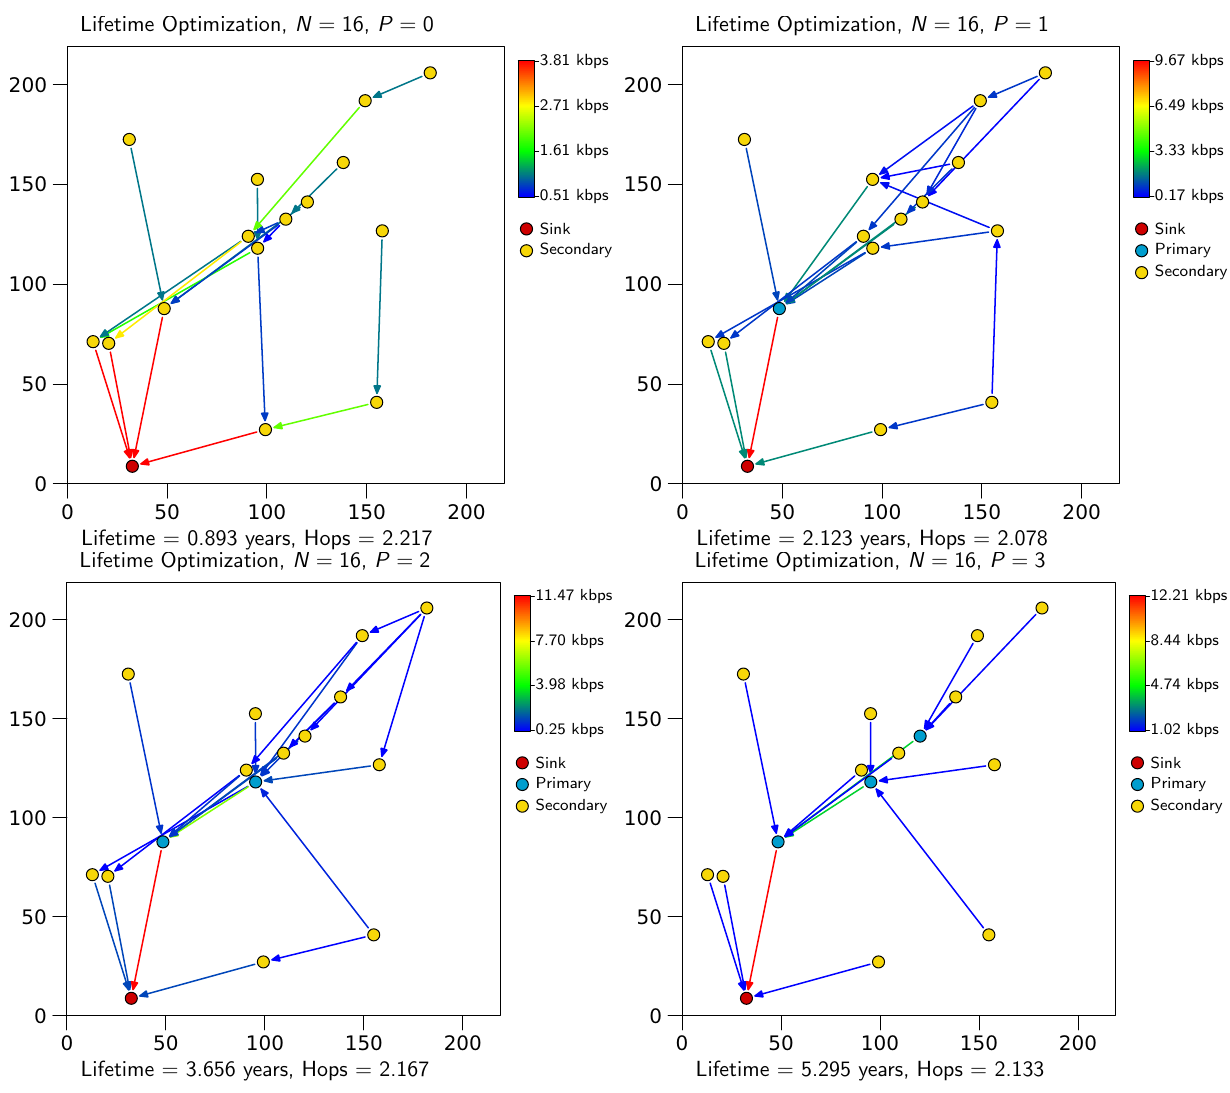
Figure 1. Lifetime optimization example results for a scenario with 16 nodes. Note how transmission schemes change with the assignment of new primary nodes. Link colors depend on the transmission rate according to the color bar on the upper right corner of each figure.